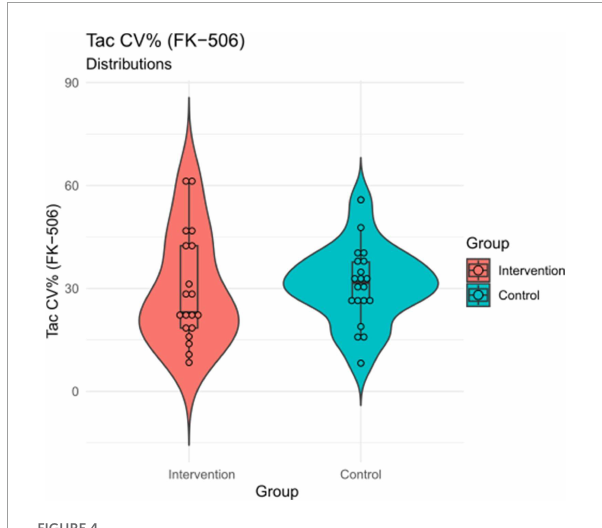
FIGURE4 TAC coefficient of variation (CV%) by group. Mean differences are displayed for descriptive purposes and not statistically significant (see Table 2 ).